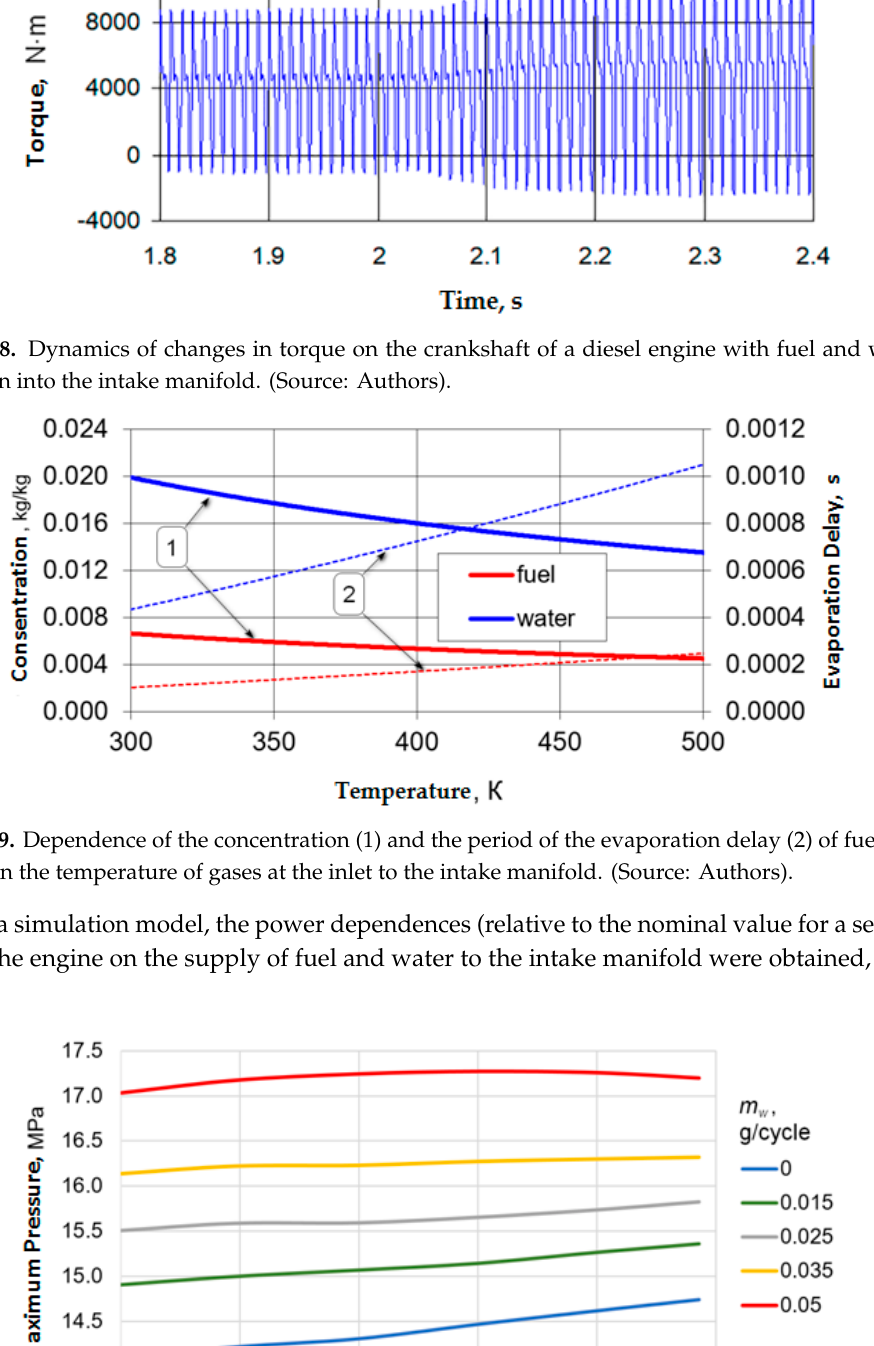
Figure 8. Dynamics of changes in torque on the crankshaft of a diesel engine with fuel and water injection into the intake manifold. (Source: Authors).